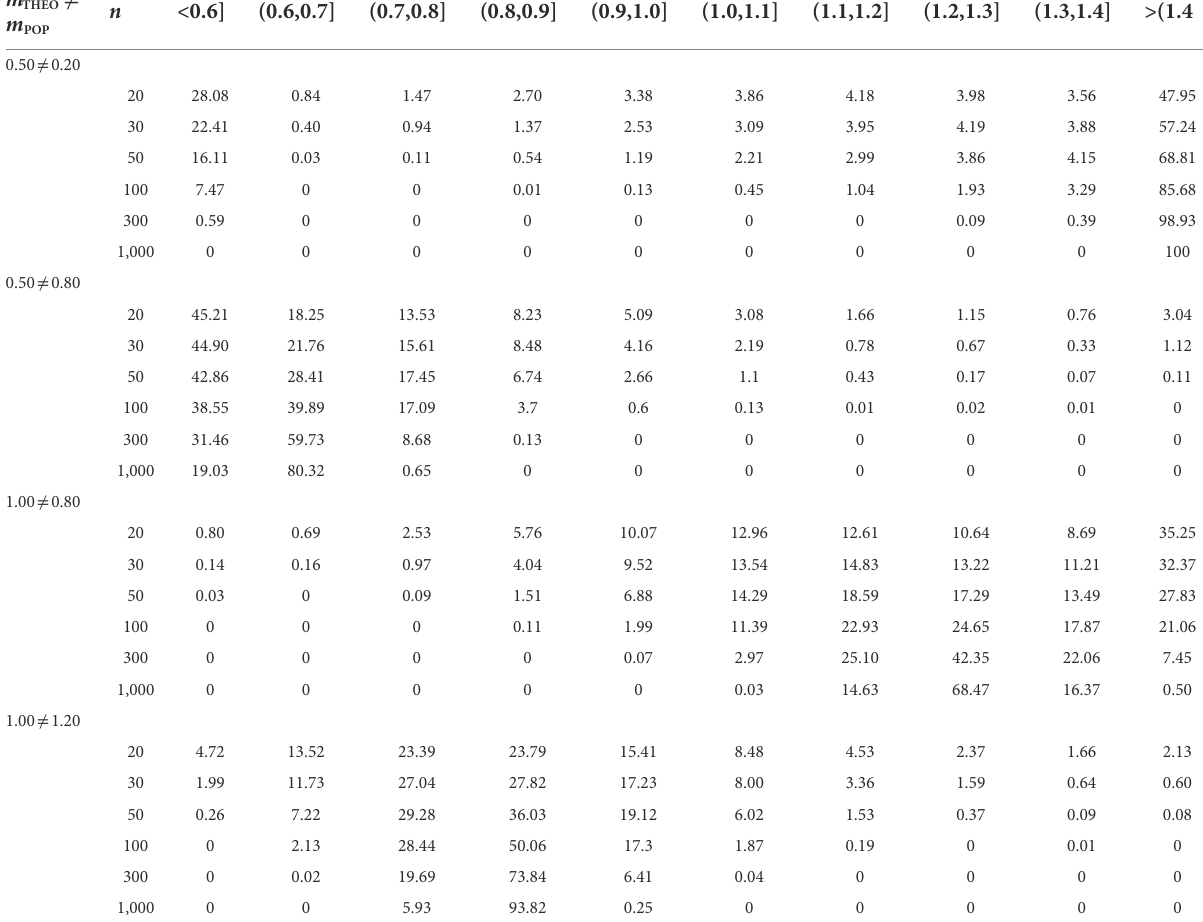
TABLE 2 False predictions (ES THEO ≠ ES POP ): expected I SIM -values given discrepancies between ES THEO ( m THEO – m 0 ) and ES POP ( m POP – m 0 ) for varying n . m THEO ≠ n <0.6] m POP 0.50 ≠